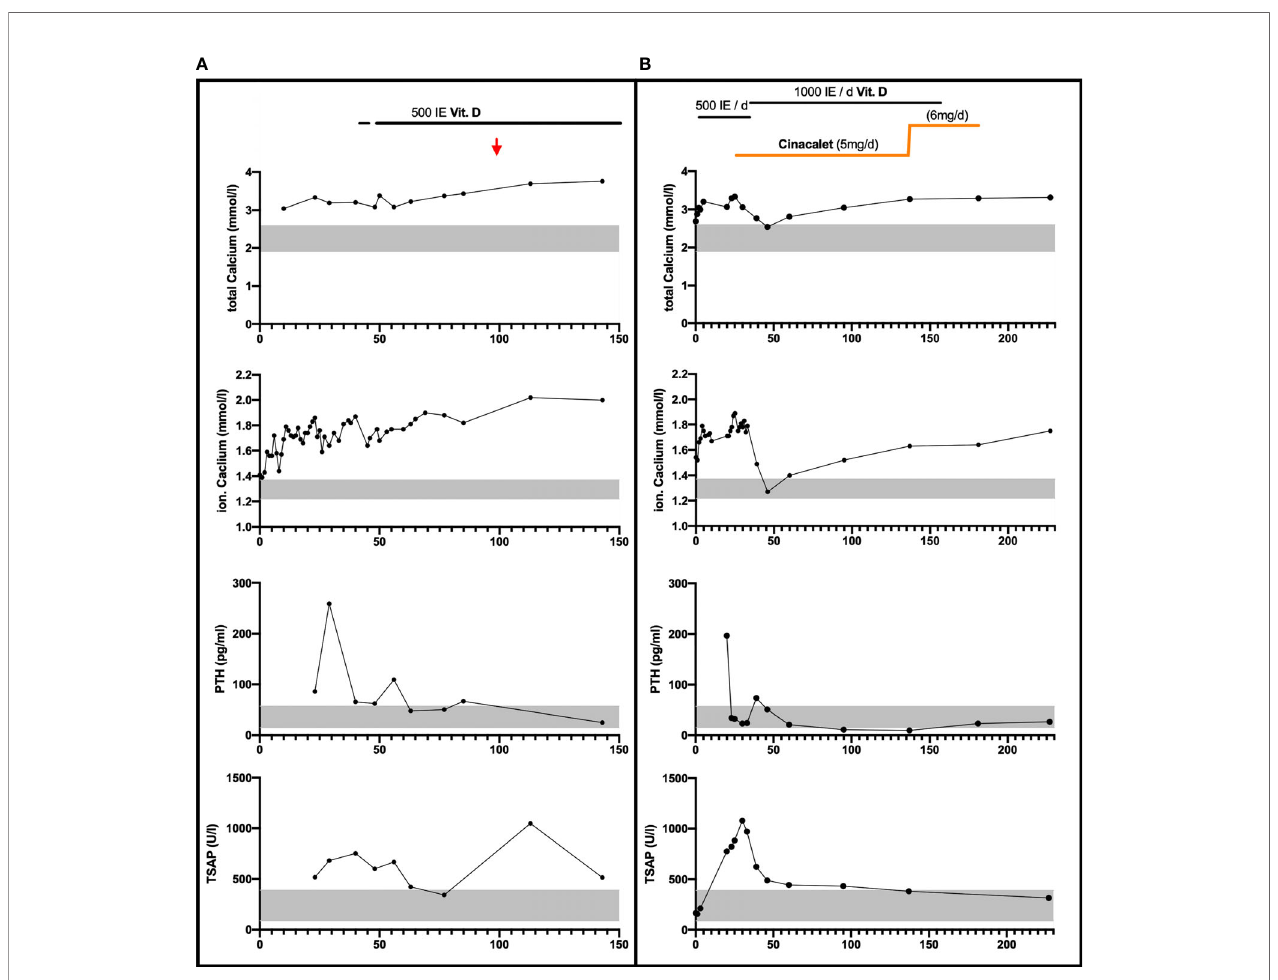
FIGURE 1 | Laboratory parameters and calcium-affecting treatments over the fi rst 150 respectively 240 days in Patient 1 Panel (A) and Patient 2 Panel (B) . Vitamin D3 was provided orally/once daily. Cinalcacet was started in patient 2 on day 26 of life at 20 mg/m² body surface (5mg) daily and increased on day 137 of life based on increased body weight and elevated calcium levels (to 6mg). Age-appropriate normative range is indicated by the grey bar for calcium, PTH and total serum alkaline phosphate (TSAP) levels; Red arrow: estimated date of